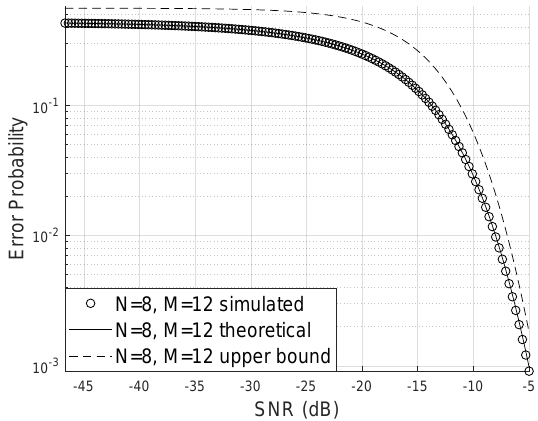
Figure 10. Proposed upper bound for the error